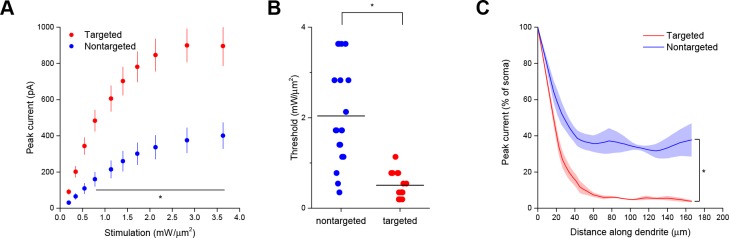
Latency to first action potential with targeted and nontargeted ChR2. (A) Evoked currents in acute slices in response to shorter 32 ms TF stimulation of increasing intensity; targeted ChR2 exhibited significantly greater current (two-way repeated measures ANOVA, p=1.951 × 10–4 for main effect of targeting, p=0.01 for targeting × power interaction, *p<0.05 Holm-Bonferroni post hoc test). (B) Minimum TF power required to elicit a single action potential. Each point indicates a single cell; cells expressing targeted ChR2 had a much lower threshold (*p=9.124 × 10–6, Mann-Whitney U Test). (C) Mean (solid lines) ± s.e.m. (shaded regions) for current responses to TF stimulation measured at specific points along a single dendrite (N=6 nontargeted cells and 6 targeted cells). Fitting each curve with an exponential function demonstrated that the nontargeted and targeted datasets were significantly different (*p<0.05 by F-test).